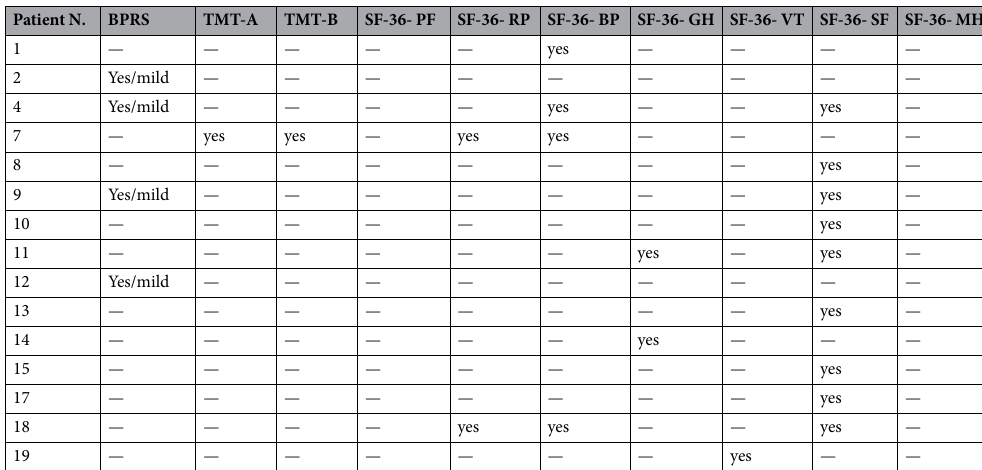
Table 3. Pathological findings at psychiatric assessment. BPRS: Brief Psychiatry Rating Scale; TMT: Trail making test; SF-36: Short Form Health Survey; PF: Physical functioning; RP: Role-physical; BP: Bodily Pain; GH: General Health; VT: Vitality; SF: Social Functioning; MH: Mental Health. Yes indicates pathological findings. Patient N. 6 refused psychiatric assessment. Patient N. 3, N. 5, N. 16 displayed no pathological findings (not